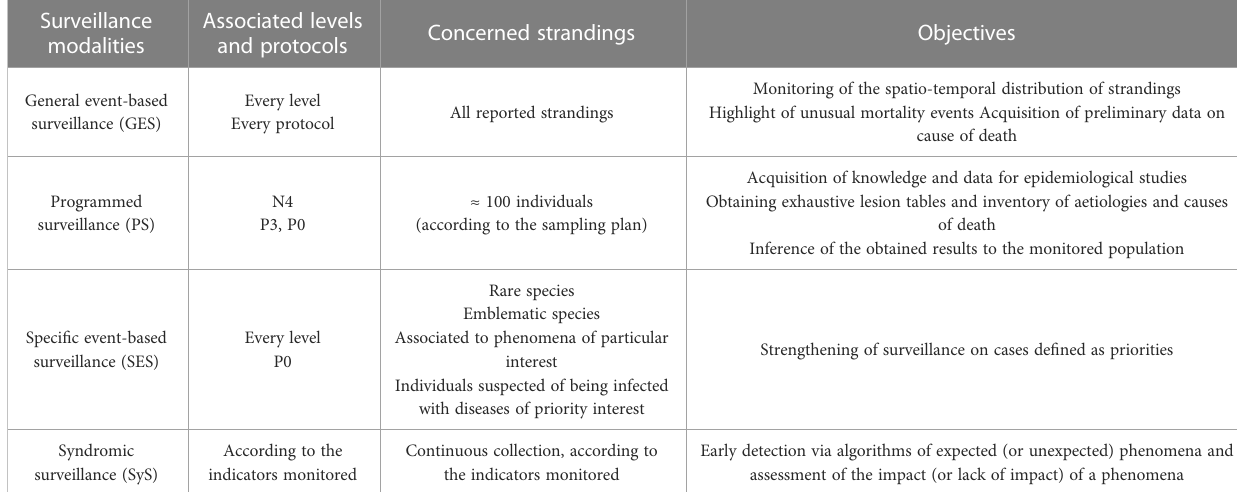
TABLE 2 Summary of the four monitoring